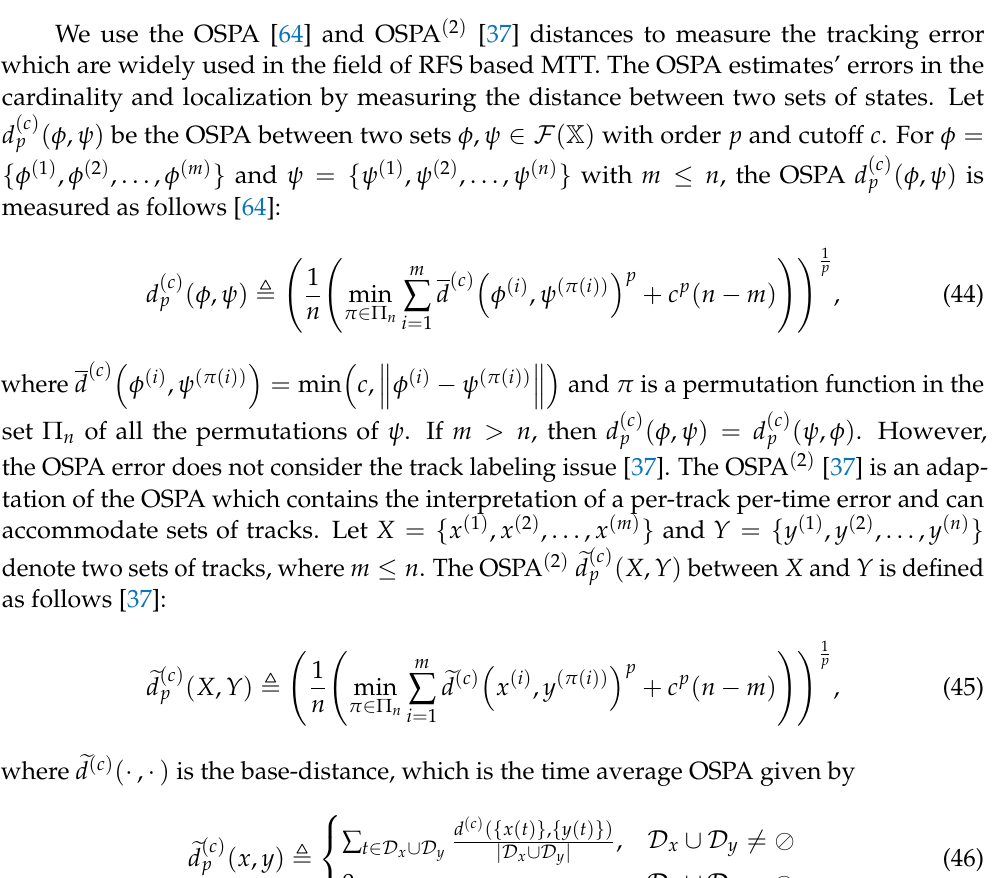
Figure 7. The locations of Doppler